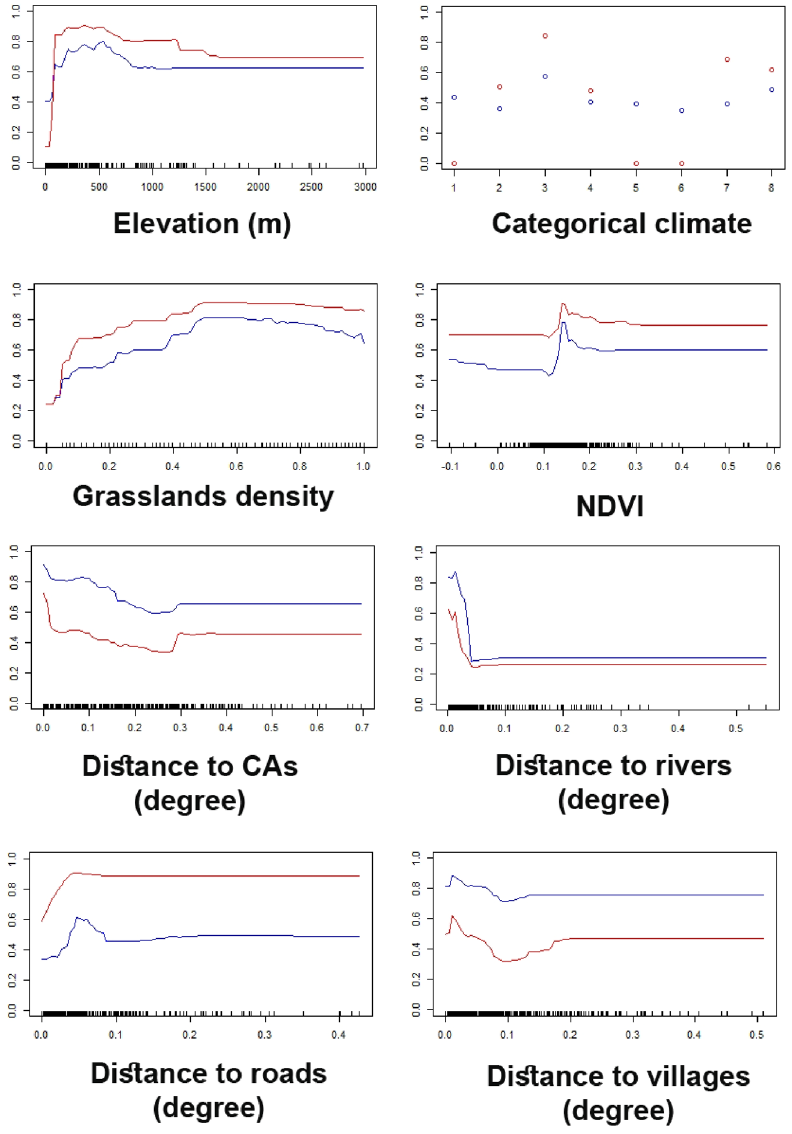
Figure 2. Response curves of occurrence points of the striped hyaena to the environmental variables (the two most accurate models of RF [red] and GBM [blue] were considered). Y-axis represents the probability of the striped hyaena occurrence. X-axis of categorical climate variable represents: (1) sea and lake, (2) semi-humid, (3) semi-arid, (4) humid, (5) very arid, (6) very humid, (7) Arid and (8) Mediterranean (each 0.1 geographical degree in the study area is approximately equal to 13.2